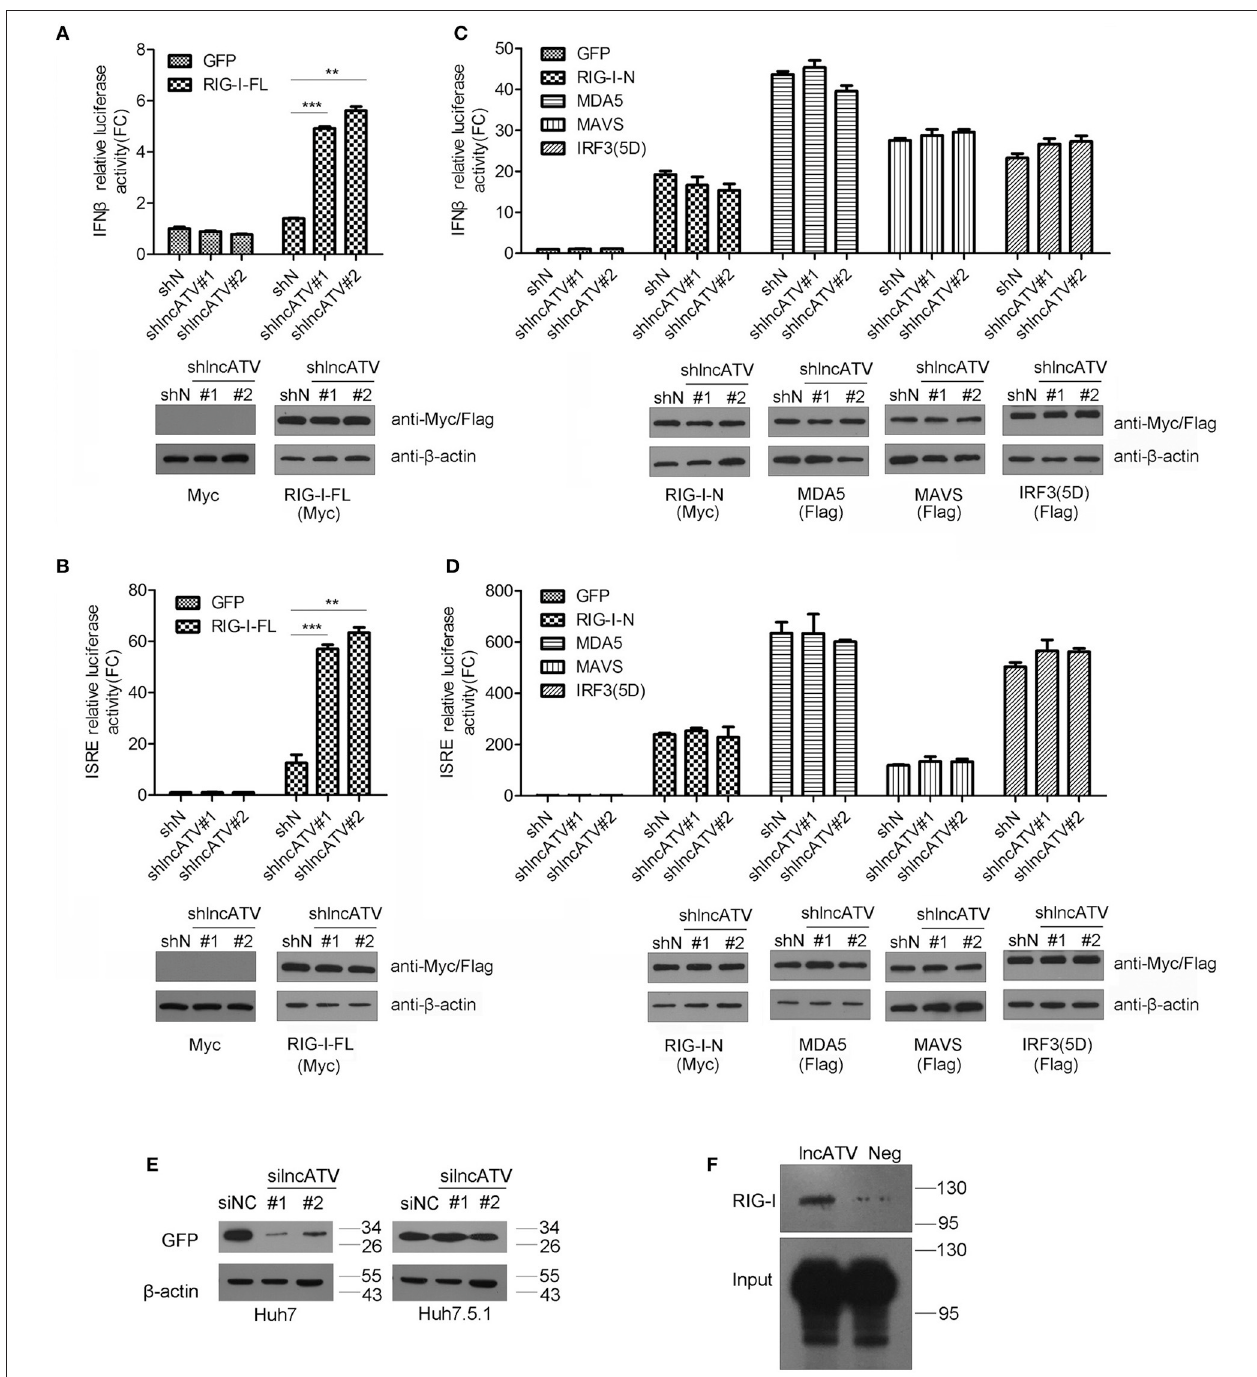
FIGURE 4 | LncATV negatively regulates RIG-I-mediated antiviral signaling. (A,B) IFN β (A) or ISRE (B) promoter-driven reporter activities were determined in Huh7 cells that were transfected with lncATV silencing and full-length RIG-I (RIG-I-FL) vectors. A GFP expression vector was transfected as control (upper panel). The expression of myc-tagged RIG-I was confirmed with Western blotting (lower panel). (C,D) The experimental design was similar to that of (A) , except that plasmids encoding other RLR pathway component (N-terminal RIG-I, MDA5, MAVS, or IRF3) were used instead of the overexpression of full-length RIG-I. (E) Huh7 or RIG-I deficient Huh7.5.1 cells were transfected with negative control siRNA (siNC) or siRNA targeting lncATV at 48h prior to NDV-GFP infection. NDV replication levels were determined by Western blotting using anti-GFP antibody at 16h post-infection. (F) RNA pull-down analysis of the binding of biotinylated lncATV to the overexpressed RIG-I in Huh7 cells. GFP sequence was transcribed and labeled as a negative control (Neg). Data are representative of three independent experiments and plotted as the mean ± s.d. ** P < 0.01, *** P < 0.001 vs. the control group. NS, not significant.